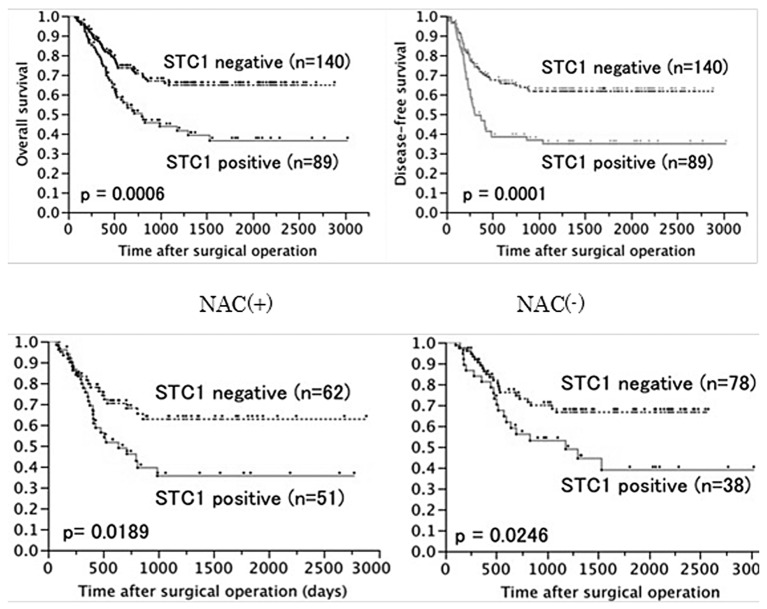
Survival rates according to STC1 expression in patients with esophageal cancer. The overall survival rate (A) and disese-free survival rate (B) classified by STC1 expression were plotted by the Kaplan-Meier method. Differences between the two groups (STC1-positive and STC1-negative) were evaluated by the log rank test. The STC1-positive group showed siginificantly poorer prognosis for both overall survival and disease-free survival than the STC1-negative group. (C) Overall survival rates of patients who received NAC according to STC1 expression. (D) Overall survival rates for patients treated by surgery alone according to STC1 expression.